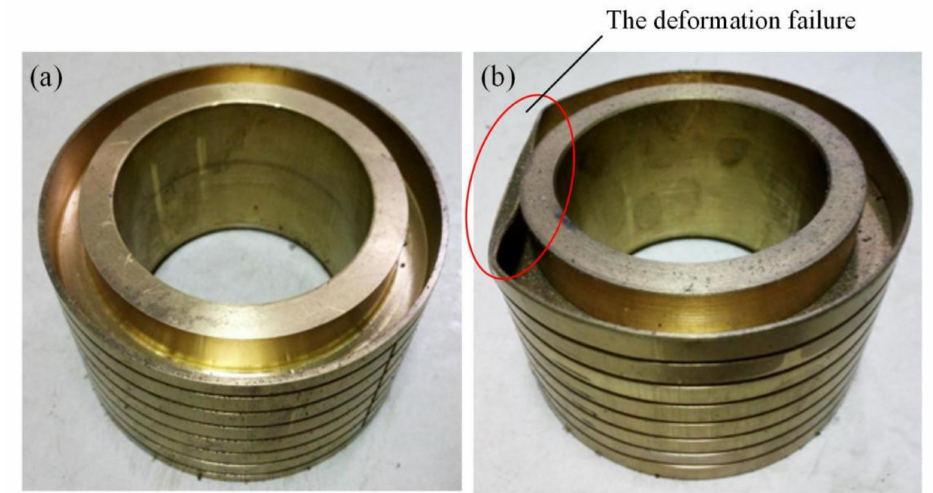
Figure 2. The structure of the piston lip: ( a ) normal and ( b ) deformed piston lip